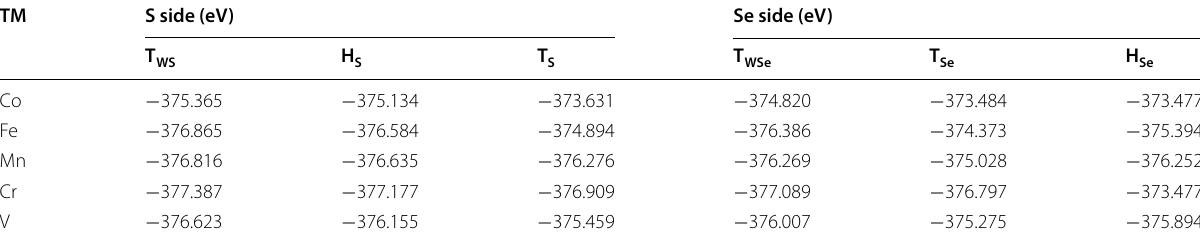
Table 1 The total energy for different configurations